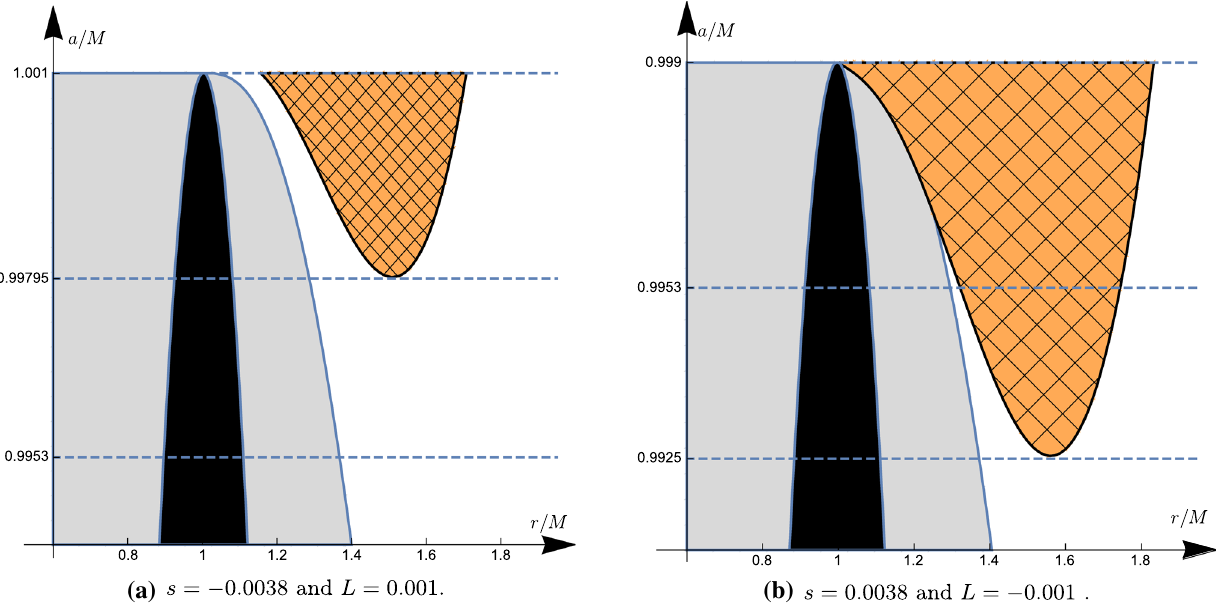
Fig. 5 Example of the a − r parameter space with a c greater and lower than original pure Kerr value a c = 0 . 9953. The hatched regions correspond to the parameter space, where the Aschenbach effect can be observed in general